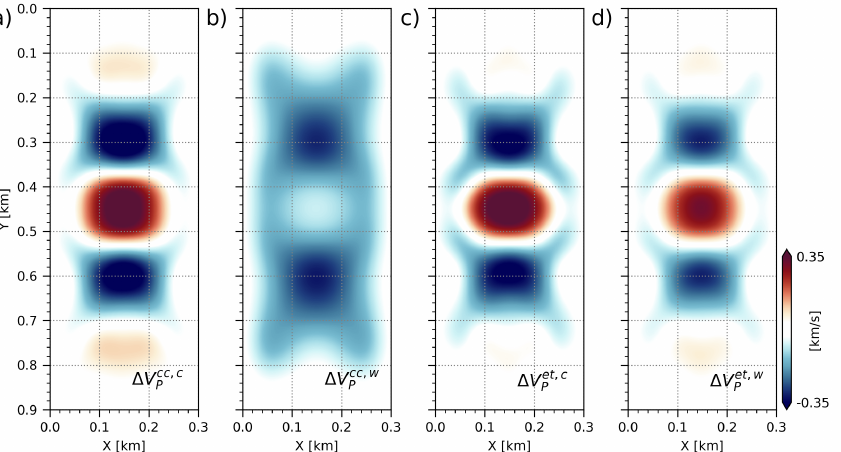
and ∆ V cc , w by the P P